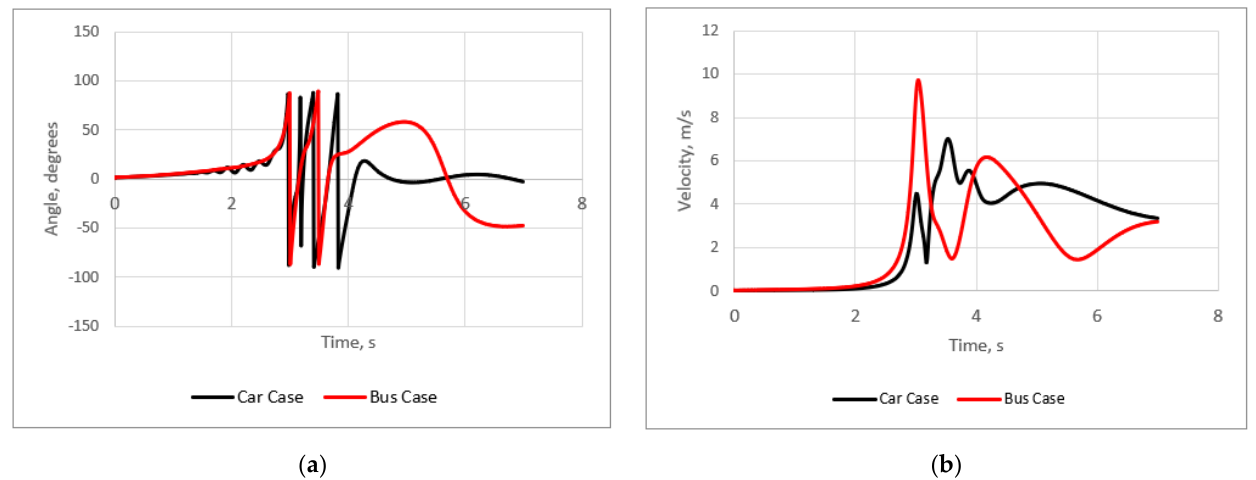
Figure 25. ( a ) Instantaneous wind direction at the rotor zone for car and bus models; ( b ) Instantaneous wind magnitude at the rotor zone for car and bus models.